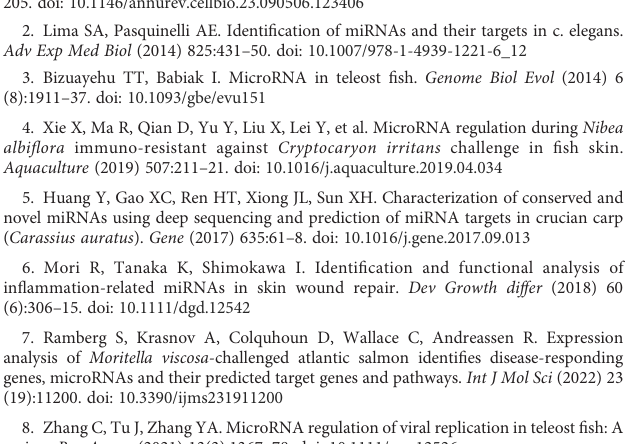
SUPPLEMENTARY TABLE 3 Summary of high-throughput sequencing from gill libraries of C. auratus infected with A. hydrophila . SUPPLEMENTARY TABLE 4 Summary of sequenced miRNAs in the gills of C. auratus. SUPPLEMENTARY TABLE 5 The iTRAQ analysis of enriched KEGG pathways in the gills of C. auratus challenged with A. hydrophila